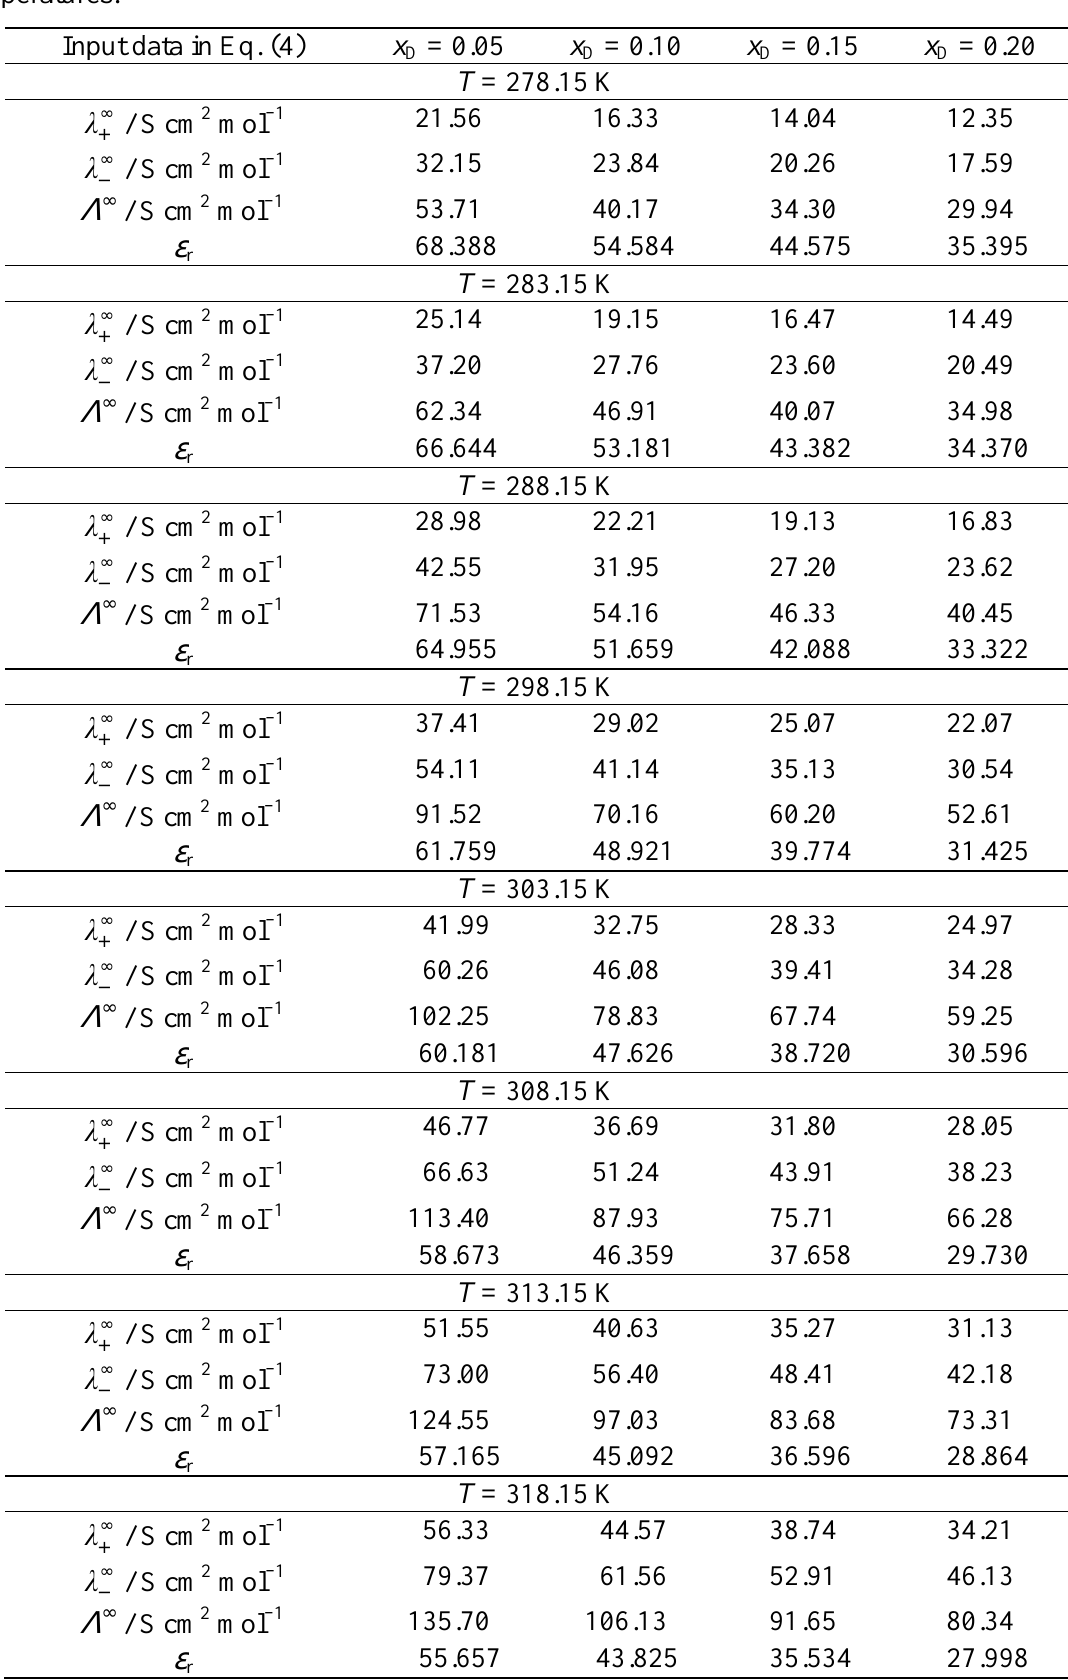
Table S1. Parameters used in Eq. (4) in aqueous mixtures of 1,4-dioxane at different